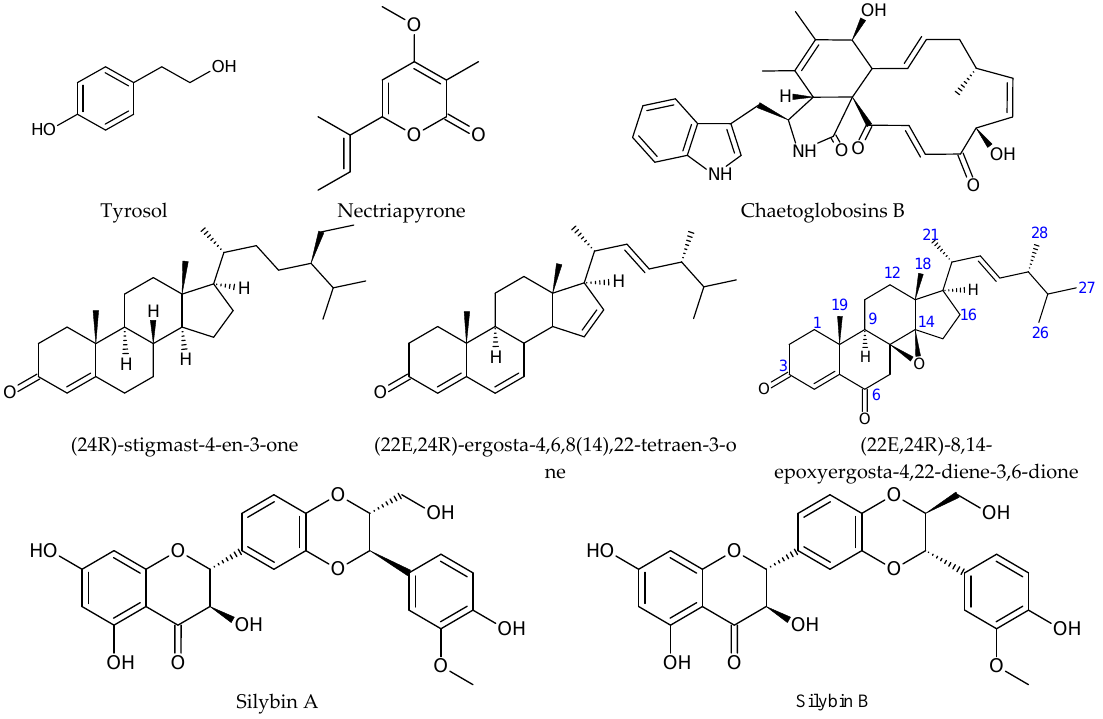
Figure 6. The molecular structure of chosen specific compounds with cytotoxic activity synthesized by fungal endophytes associated with Asteraceae species [99,103,105,110,114].